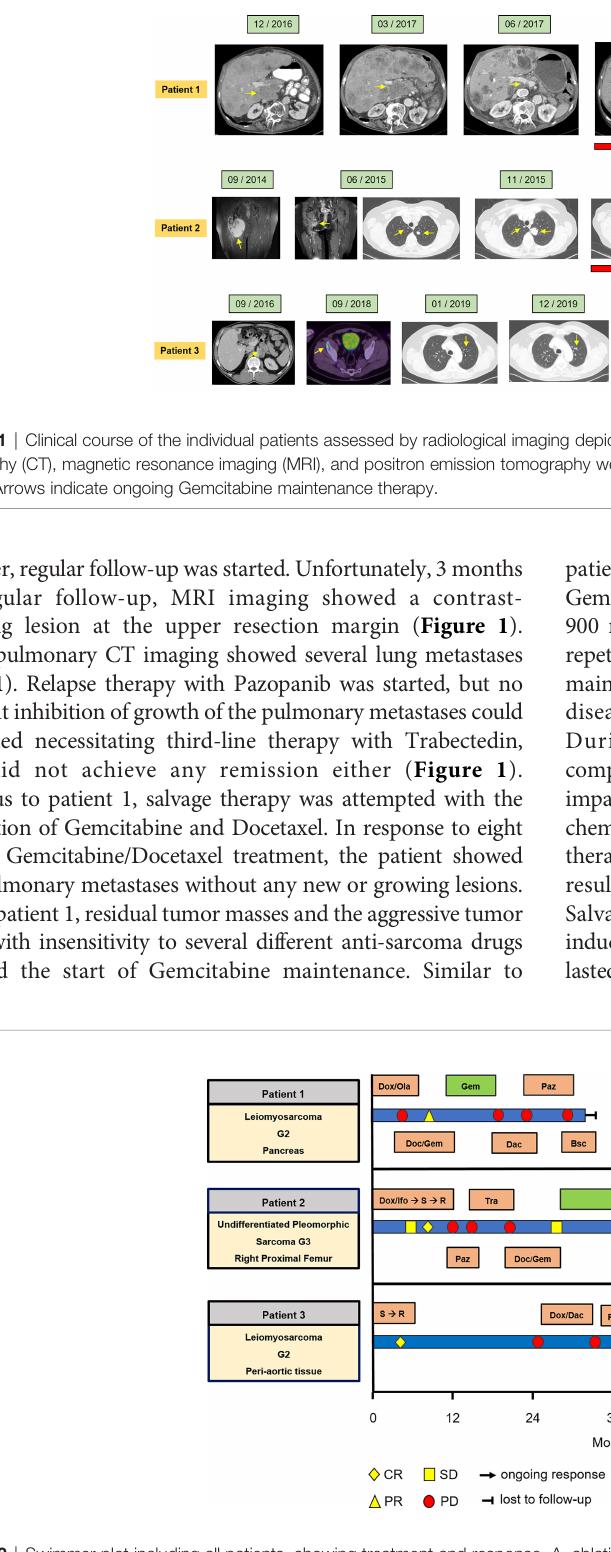
FIGURE 2 | Swimmer plot including all patients, showing treatment and response. A, ablation; Bsc, best supportive care; Dac, Dacarbazine; Doc, Docetaxel; Dox, Doxorubicin; Gem, Gemcitabine; Ifo, Ifosfamide; Ola, Olaratumab; Paz, Pazopanib; R, radiation; Reg, Regorafenib; S, surgery; Tra, Trabectedin.